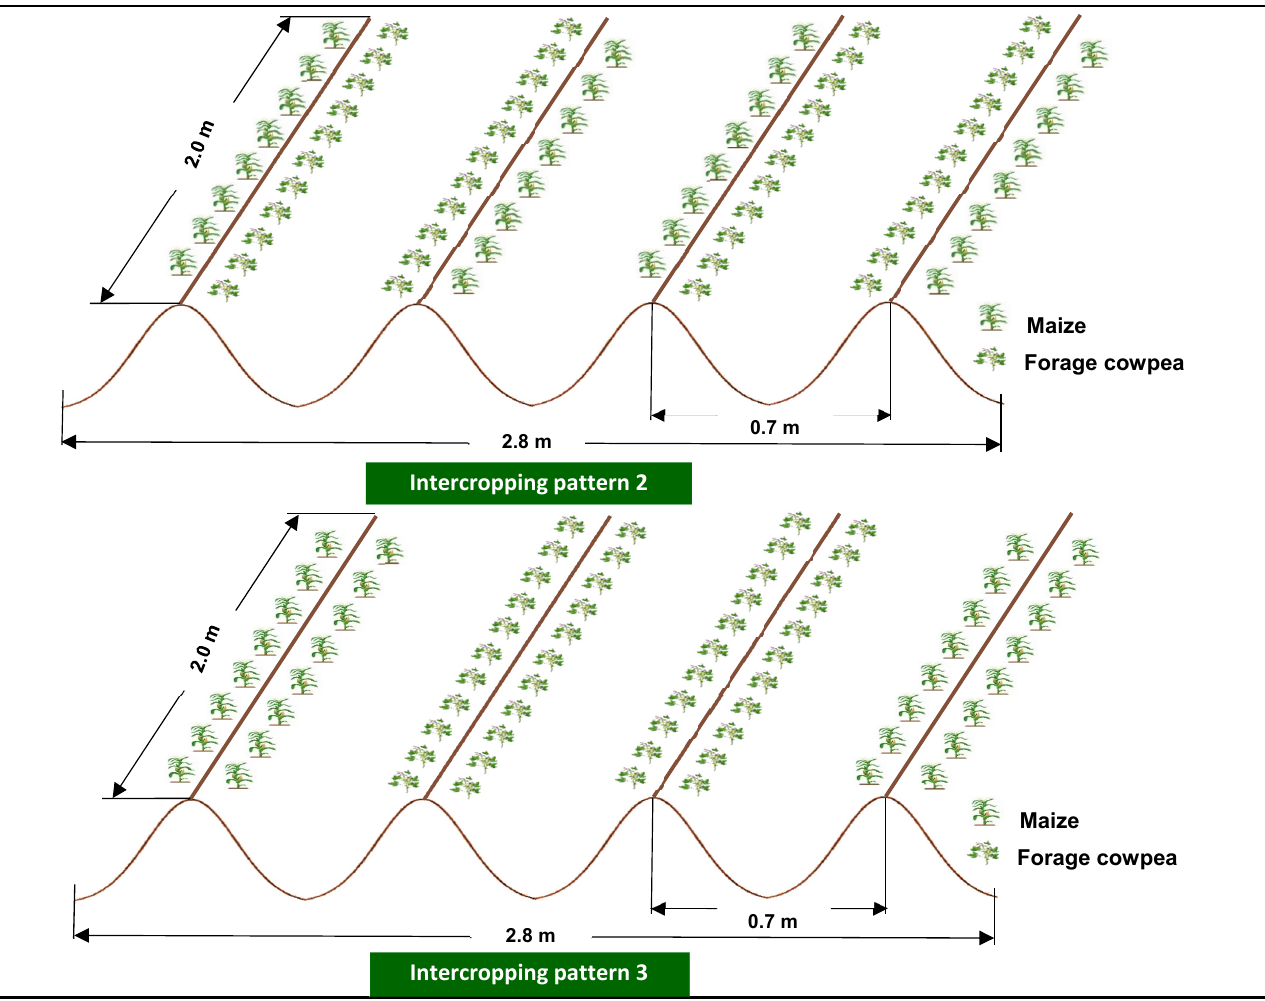
Figure 2. Experimental plot design illustrating the three evaluated intercropping patters (IP) of maize and forage cowpea.